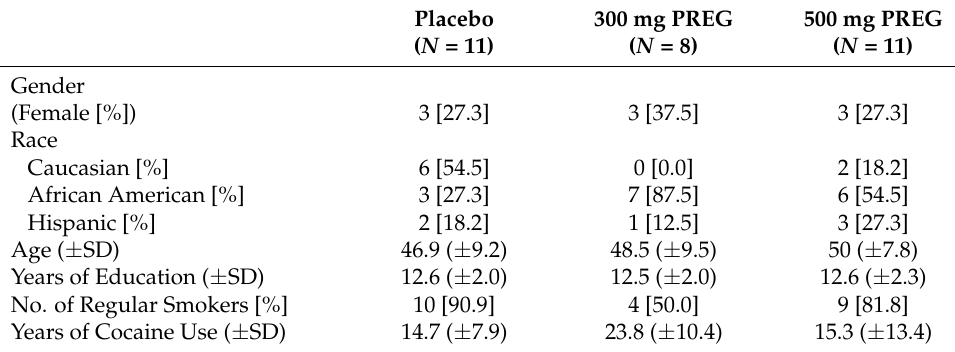
Table 1. Demographic Characteristics of the Sample.